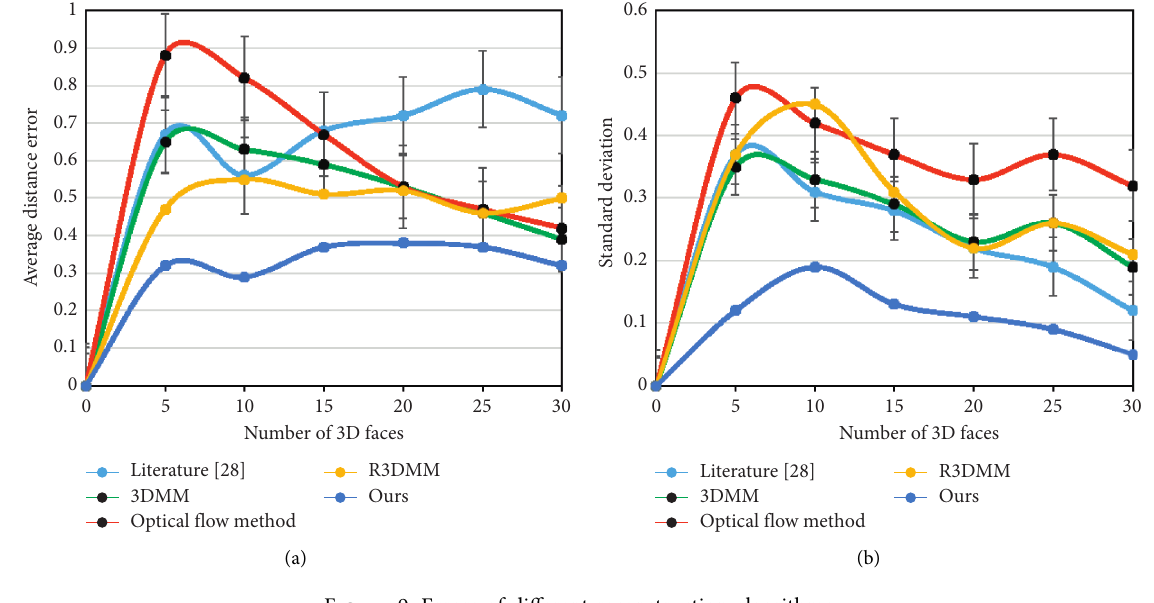
Figure 9: Errors of different reconstruction